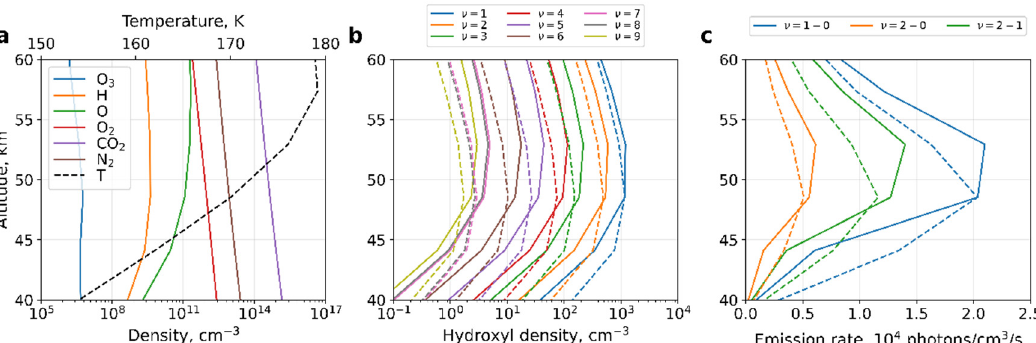
Figure 1. Night-time zonal mean quantities averaged between 70°N and 90°N and over the period of solar longitudes L s = 265°–320°: ( a ) O, O 3 , H, O 2 , CO 2 , N 2 , T from MCD; ( b ) OH v = 1,…,9 , calculated with (1) (solid lines) and estimated with (7) (dashed lines); ( c ) volume emissions from (1) and (7) (solid and dashed lines, respectively) for vibrational transitions 1–0 (blue), 2–1 (green), and 2–0 (red).